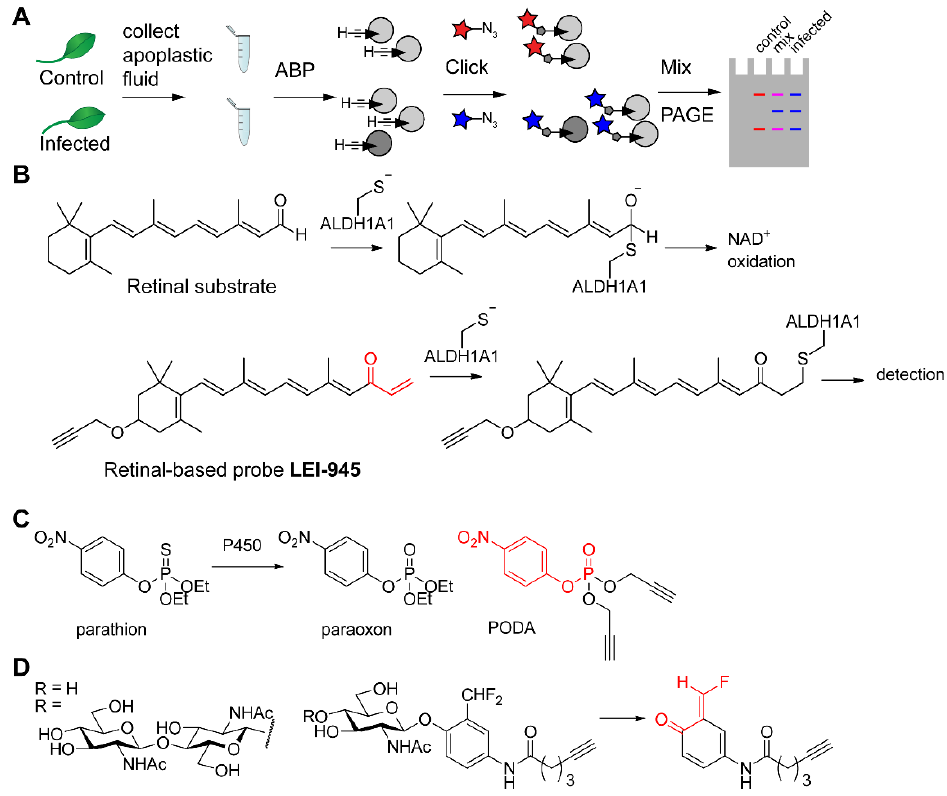
Figure 6. Profiling and discovery of enzymes by ABPP. ( A ) Schematic representation of DIGE-ABPP. Apoplastic fluid—or any other proteome—is labeled with a clickable probe, followed by CuAAC-mediated introduction of a di ff erent fluorophore in each sample. Next, samples can be mixed and analyzed. Whereas mixed colors (purple for both red and blue fluorophores) indicate similar activity of the probe targets, red or blue fluorescence reveals targets that are active only in control or infected sample. ( B ) Comparison of retinal with retinal-derived probe LEI-945 and its binding mechanism to aldehyde dehydrogenase ALDH1A1. ( C ) Structures of the pesticide parathion, the metabolite paraoxon, and the derived probe PODA. ( D ) N -Acetylglucosamine- and chitobiose-based ABPs and their binding mechanism: after cleavage of the carbohydrate moiety, a quinone-methide electrophile is formed, which reacts with a nearby nucleophile.